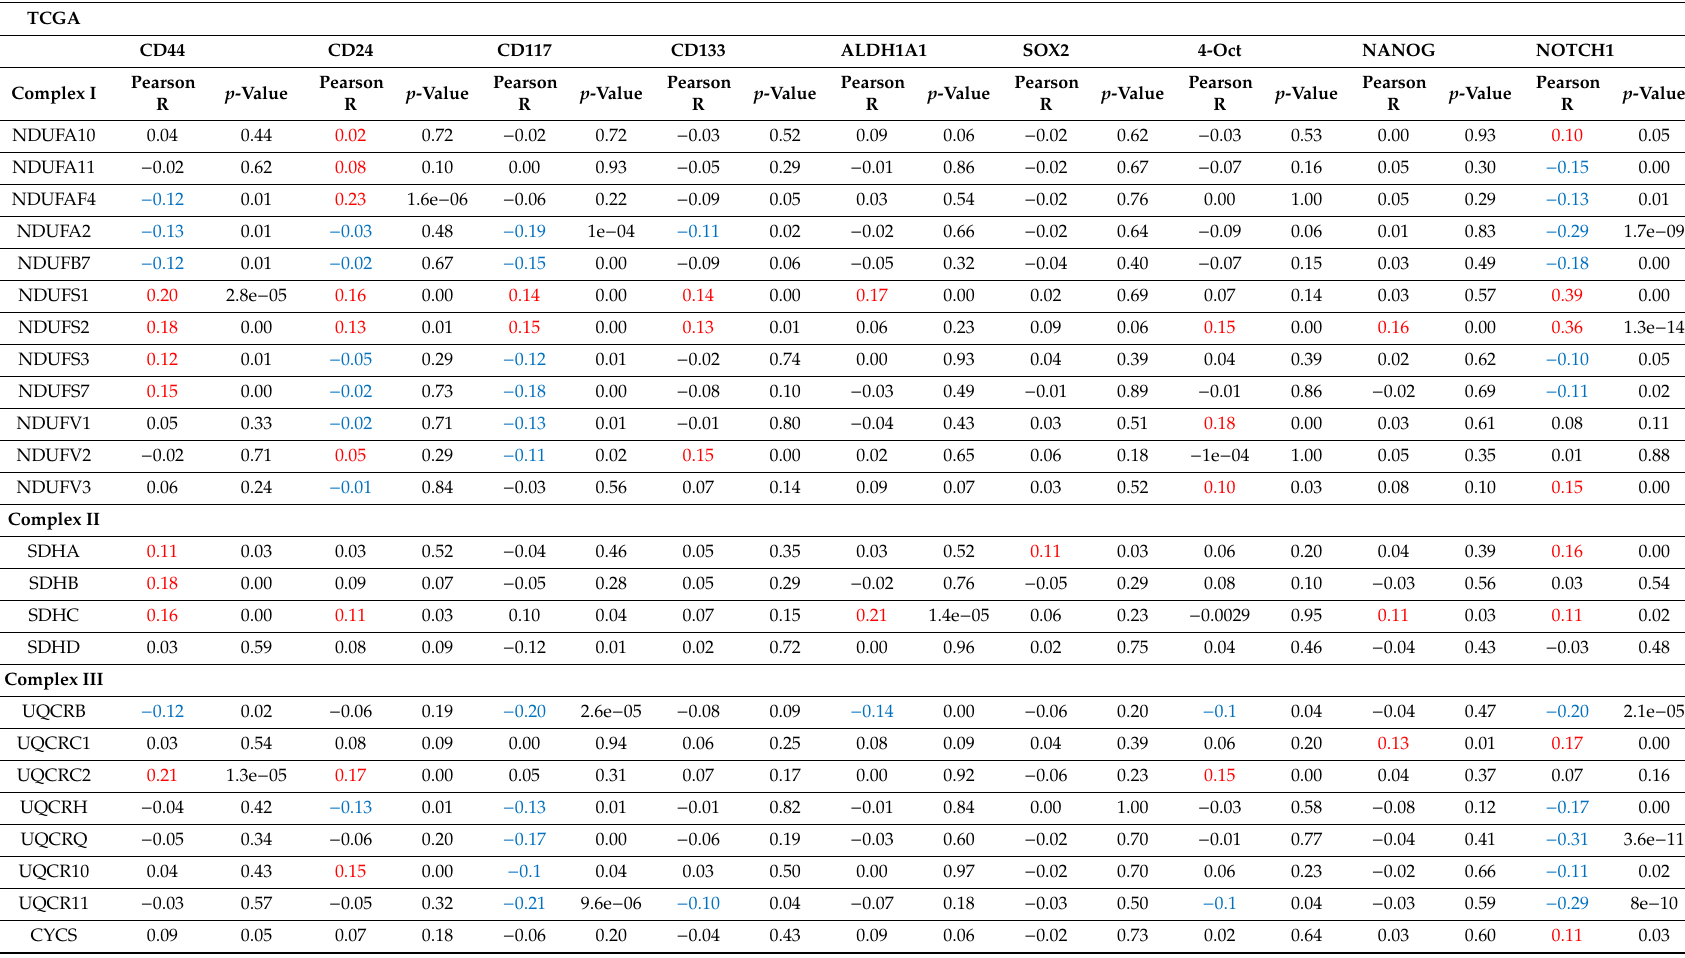
Table 3. Pearson correlation between the expression of CSC transcripts and the transcripts of the key enzymes involved in the ETC in patients’ data curated from TCGA. Red indicates significant positive, blue indicates negative correlations, and black indicates insignificant p -values of either positive or negative correlations.